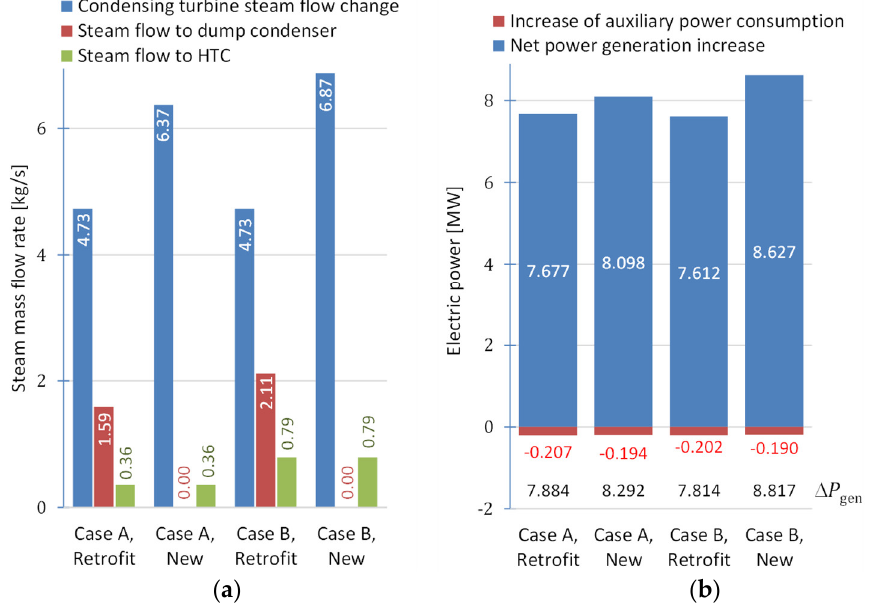
Figure 5. Change of NorInt plant steam production and use ( a ), and power generation ( b ) with biosludge HTC treatment. In all cases, CFB boiler main steam production for TG2 increases by 9.24 kg/s. KRB and TG1 remain unchanged.